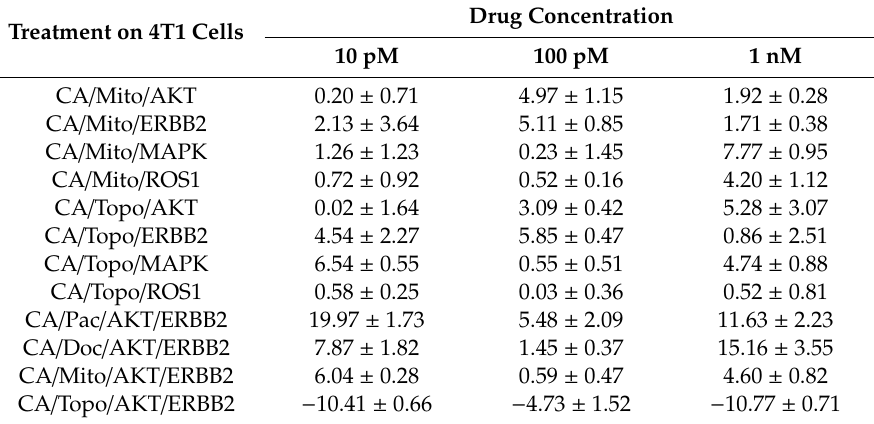
Table 7. E ff ect of silencing various pathways on cytotoxicity of classical anti-cancer drugs in MDA-MB-231 cells. Data is presented as mean ± SD compared to CA / drug. Treatment on MDA-MB-231